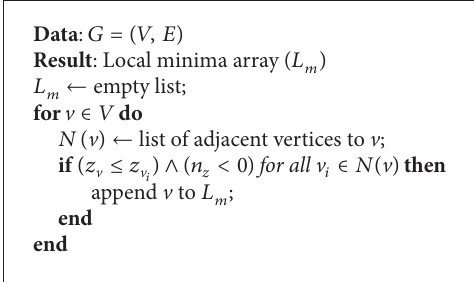
Algorithm 2: Local minima